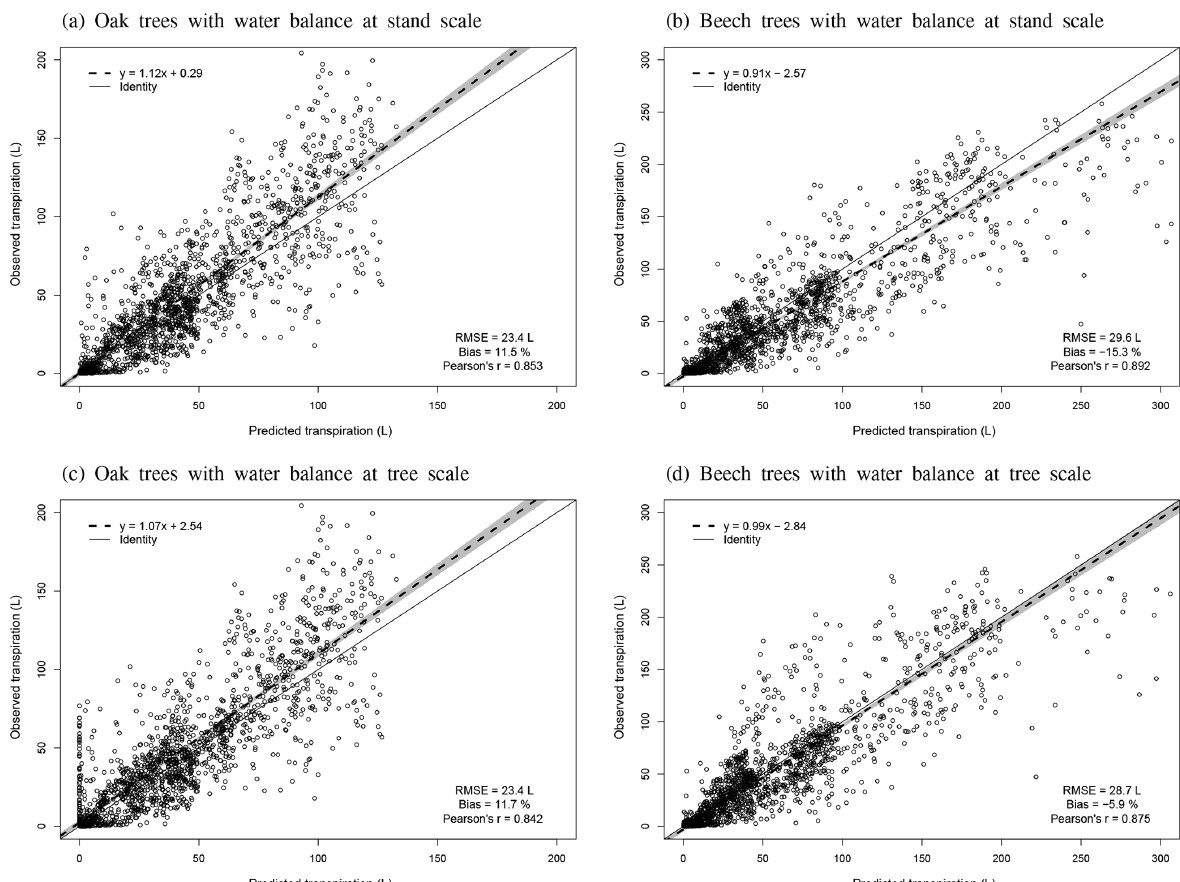
Figure 6. Comparison of the observed and predicted daily transpiration of sessile oak and European beech in 2003, considering the tree and the stand scale for the water balance calculation. The quality of predictions is indicated by the RMSE, the relative bias and the Pearson’s correlation coefficient ( r ). The shaded area represents the confidence interval of the Deming regression (95%) of observations on predictions, and the solid line corresponds to the identity